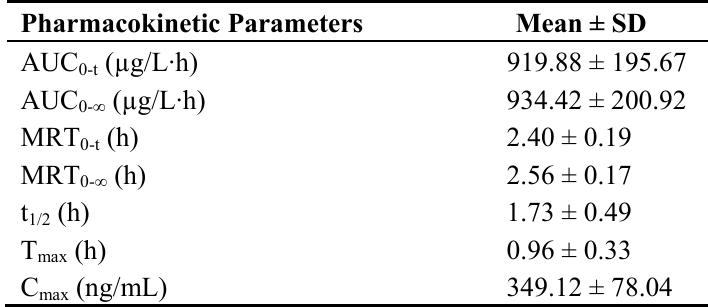
Table 4. The main pharmacokinetic parameters after a single oral administration of MP tartrate tablets (50 mg) in Beagle dogs (n =